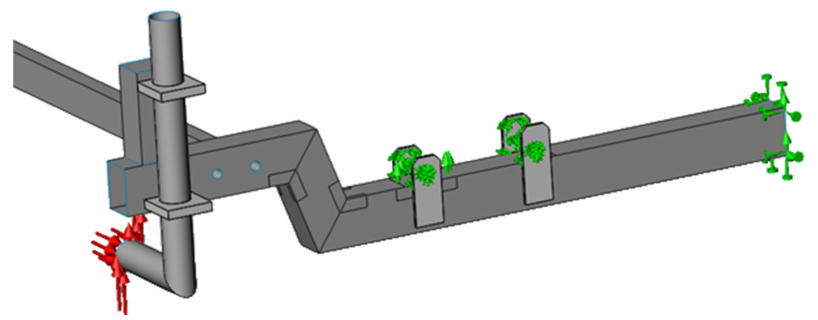
Figure 5. Mounting and loading of the ASC